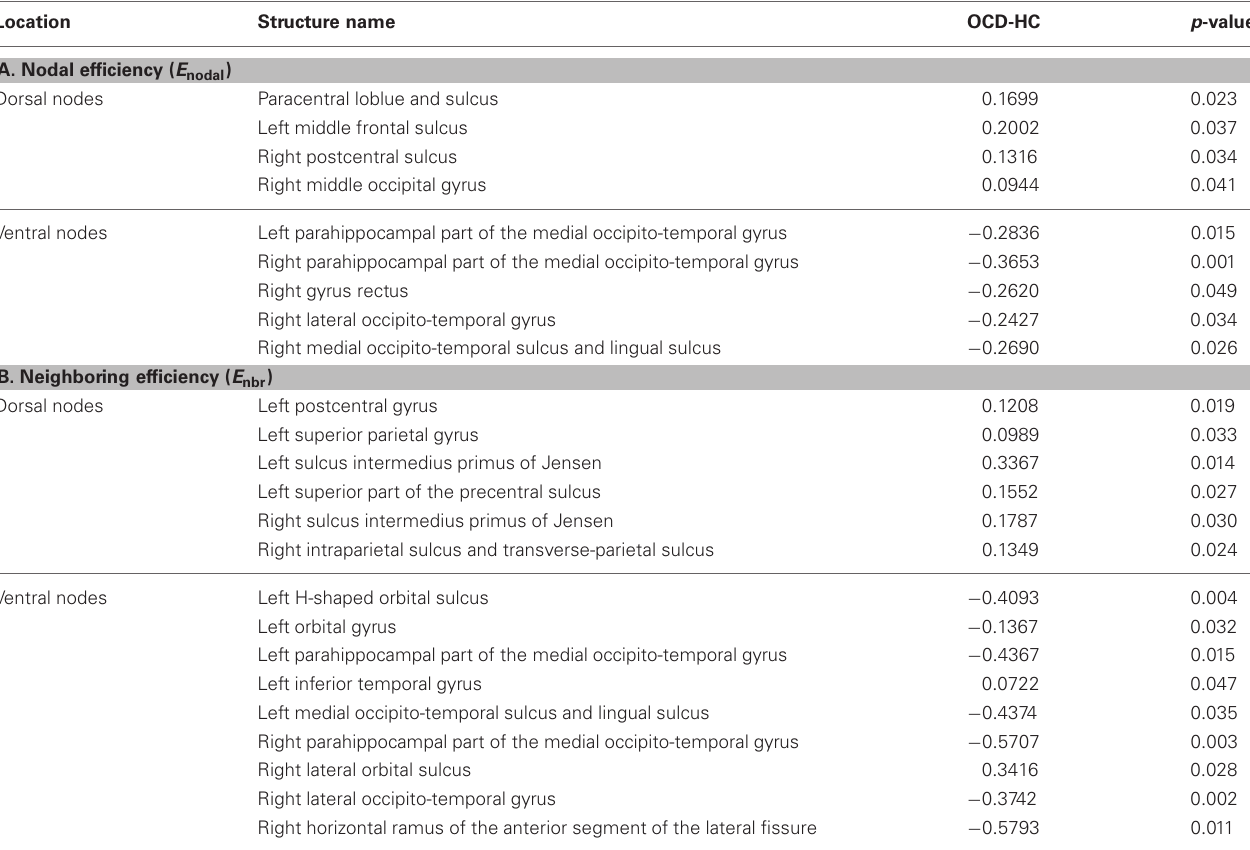
Table 2 | The summary of the nodes with significant differences in mean efficiency ( p < 0 . 05) as the subtraction of controls (HC) from the OCD patients (OCD-HC) with corresponding p -values for nodal efficiency (A) and neighboring efficiency